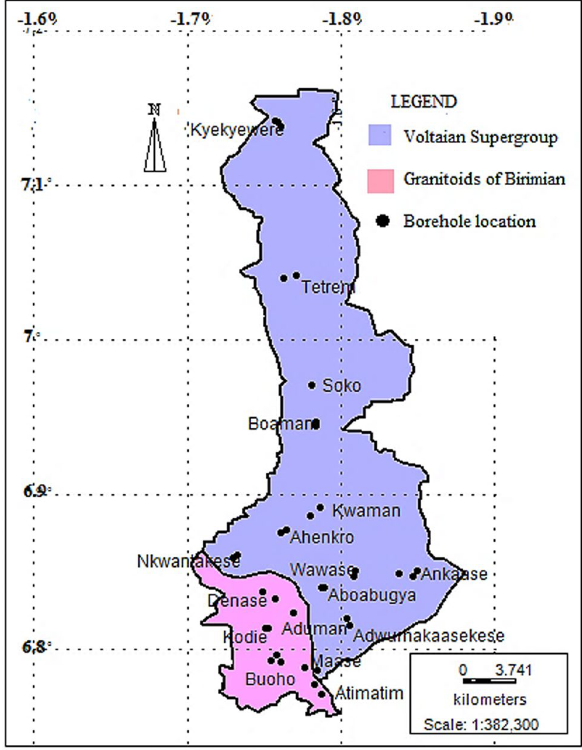
Fig. 1 The Geological map of the Afigya Kwabre District (Agyem- ang